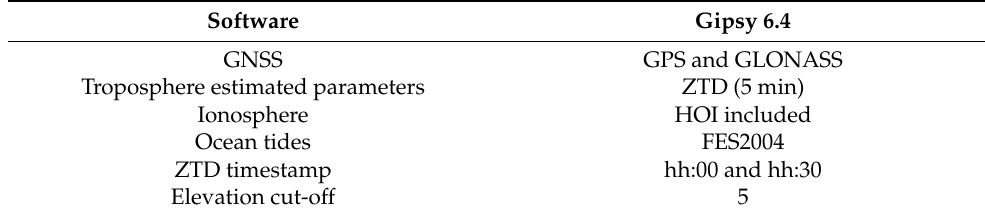
Table 1. CRL tropospheric solution settings—all